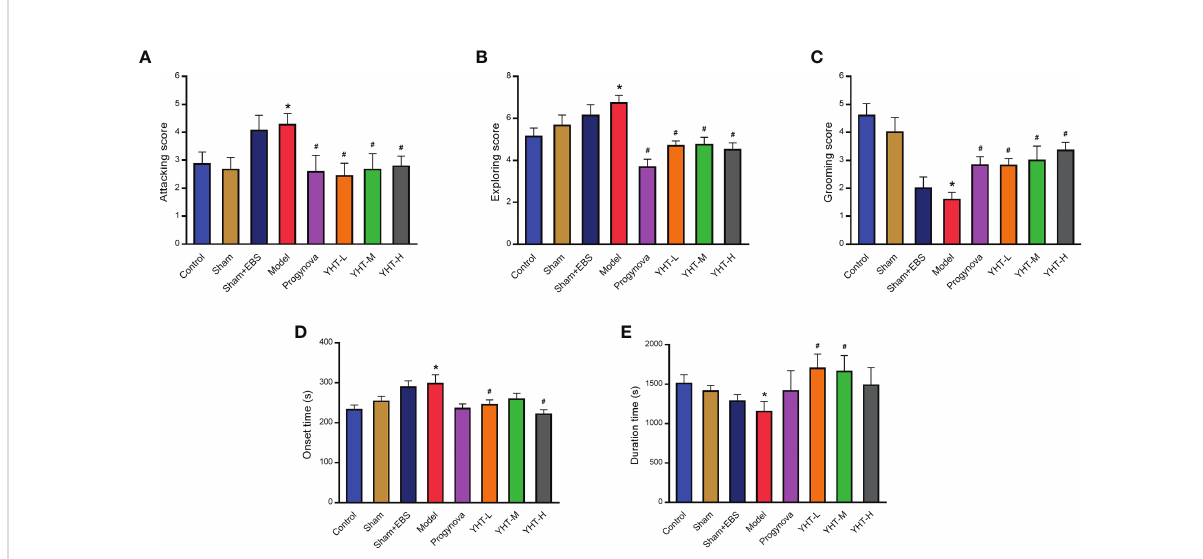
FIGURE 4 Effects of YHT on sleeping behavior and anxiety-like behavior in menopausal mice. (A) Attacking behavior. (B) Exploring behavior. (C) Grooming behavior. (D) Onset time of sleep. (E) Duration time of sleep. *p < 0.05 vs control group; #p < 0.05 vs model group. EBS, empty bottle